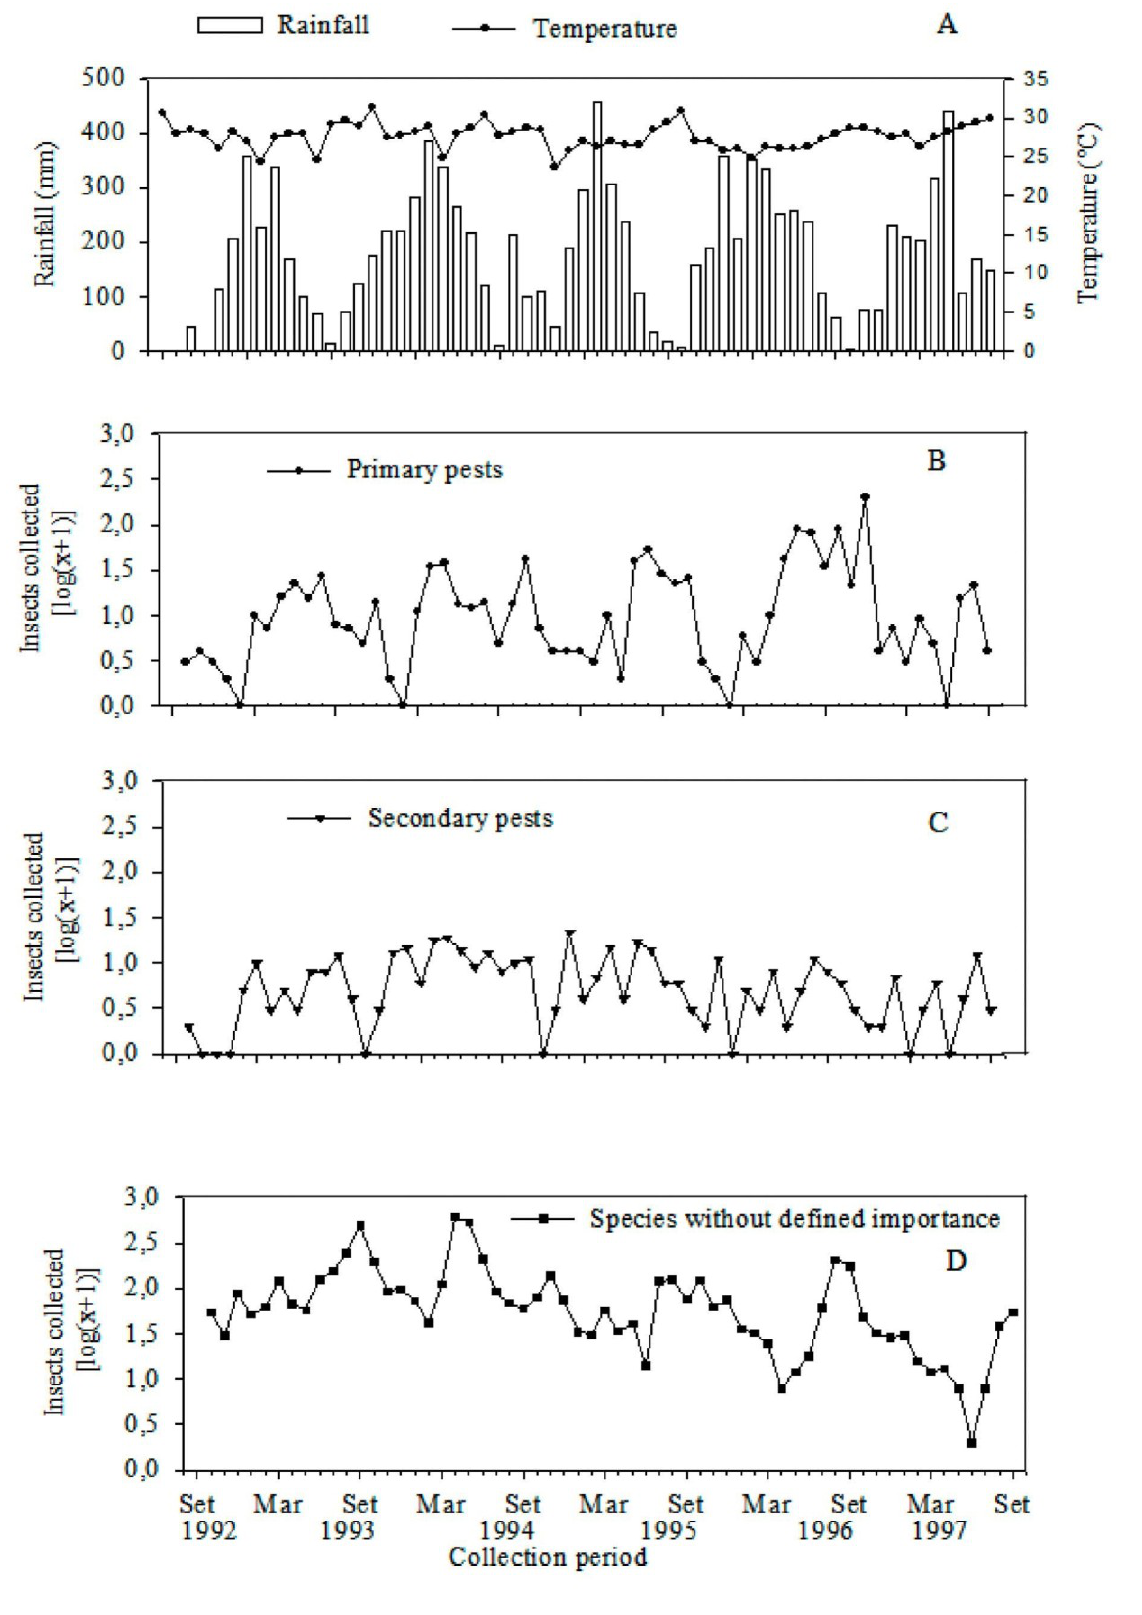
Figure 2 Rainfall (mm) and temperature (°C) ( A ), population dynamics of primary pests ( B ), secondary pests ( C ), and species with no defined importance to eucalypts ( D ) in Ponte Maria, Pará State,